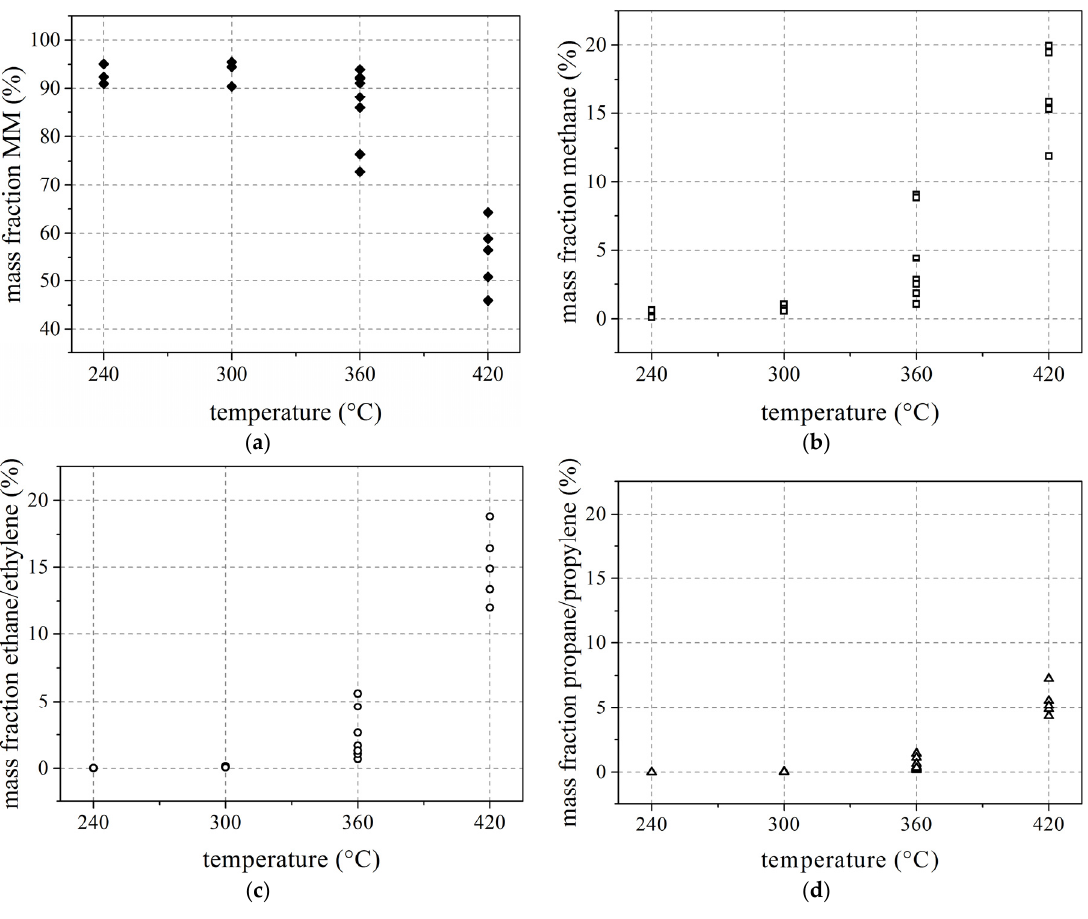
Figure 5. Mass fraction of: ( a ) hexamethyldisiloxane (MM); ( b ) methane; ( c ) ethane/ethylene and; and ( d ) propane/propylene in the vapor phase after the experiment depending on temperature ( t = 72 h).